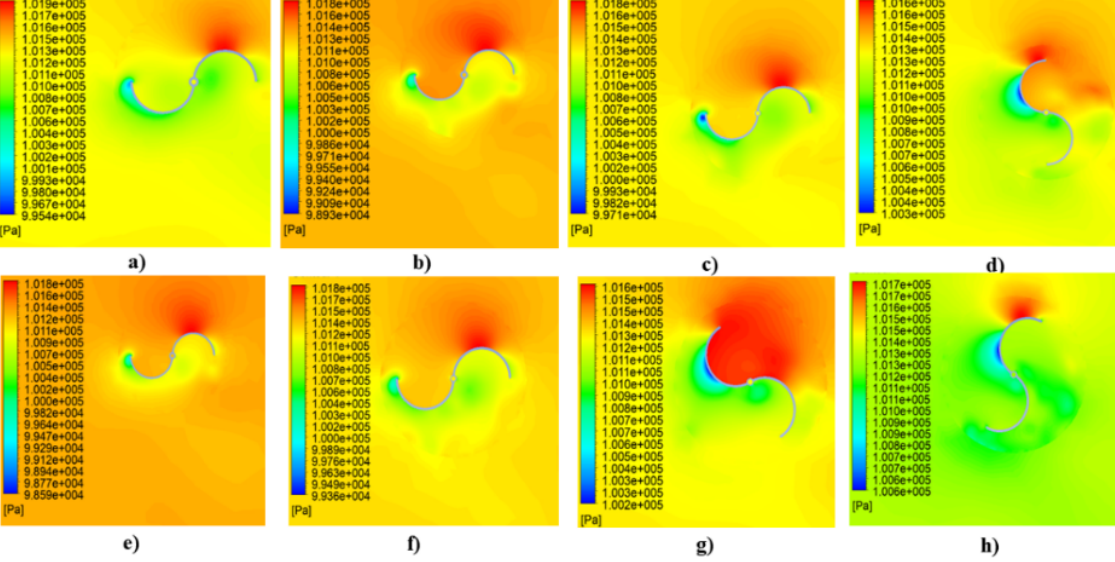
Figure 14: Distribution of pressure on a) Rotor Single Stage, b)Rotor Two-Stage 0 ∘ , c) First Stage Rotor Two-Stage 90 ∘ , d) Second Stage Rotor Two-Stage 90 ∘ , e) Rotor Three Stage 0 ∘ , f) First Stage Rotor Three Stage 120 ∘ , g) Second Stage Rotor Three Stage 120 ∘ , and h) Third Stage Rotor Three Stage 120 ∘